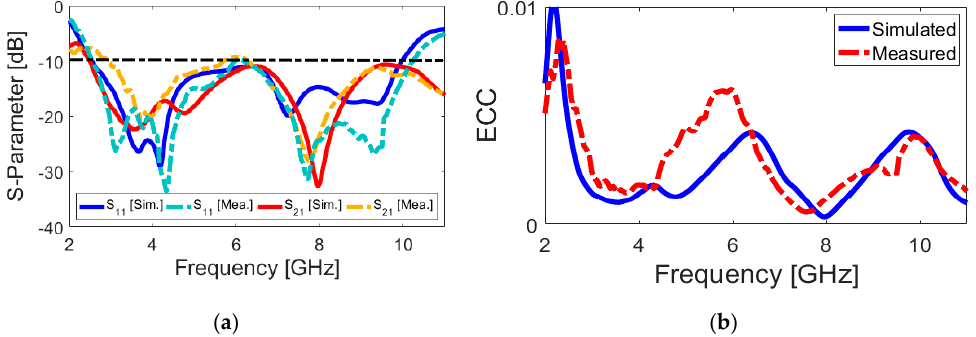
Figure 12. Measured and simulated ( a ) S-parameters and ( b ) ECC results of the proposed